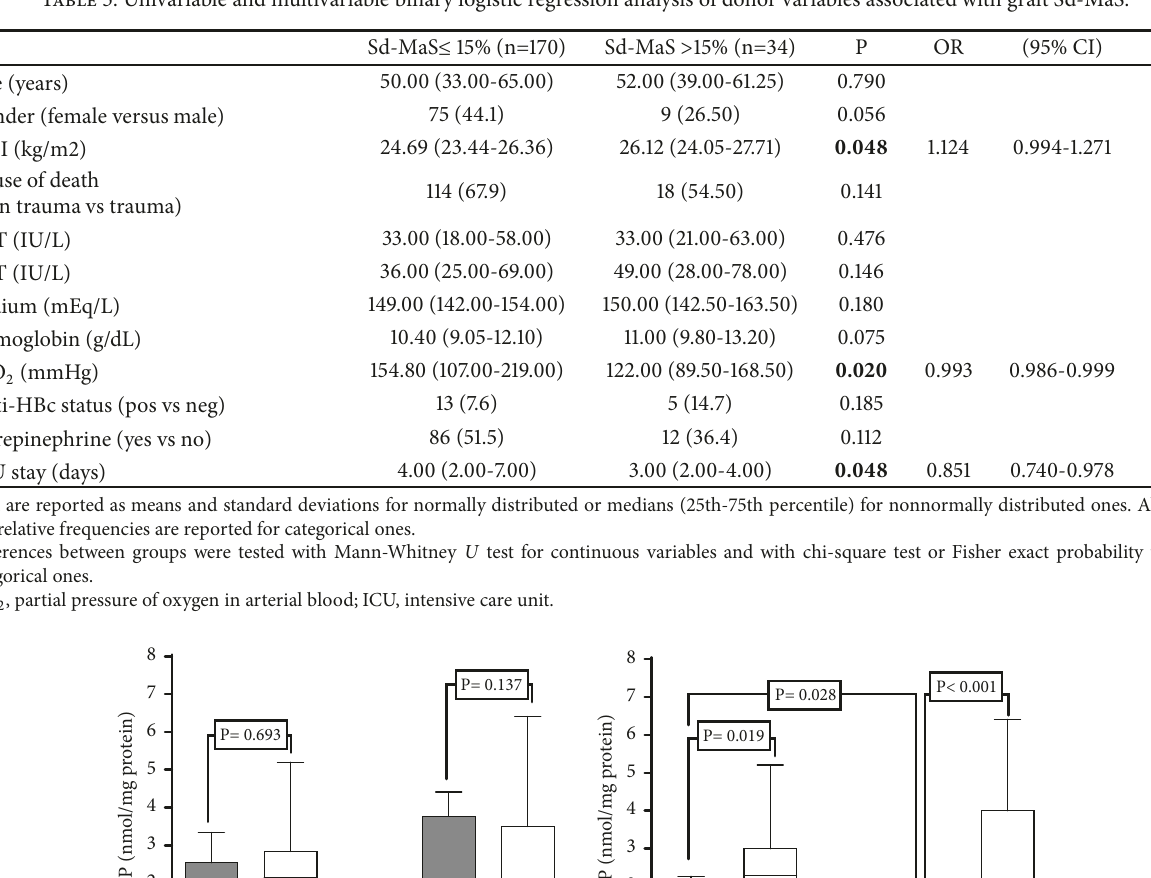
Table 5: Univariable and multivariable binary logistic regression analysis of donor variables associated with graft Sd-MaS.